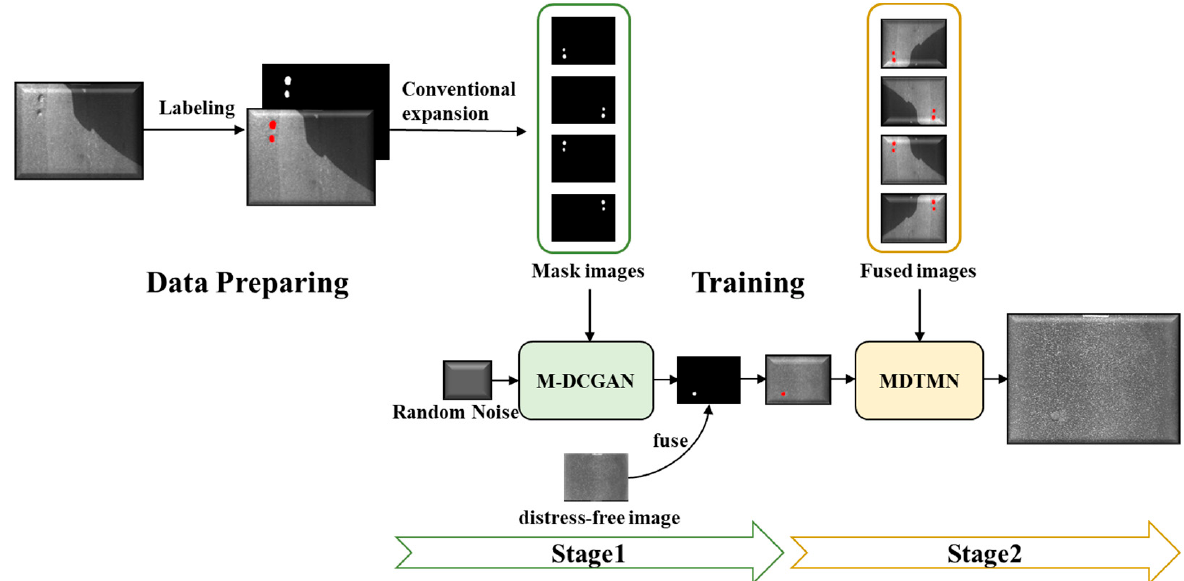
Figure 2. Flowchart of a two-stage pavement distress image augmentation.